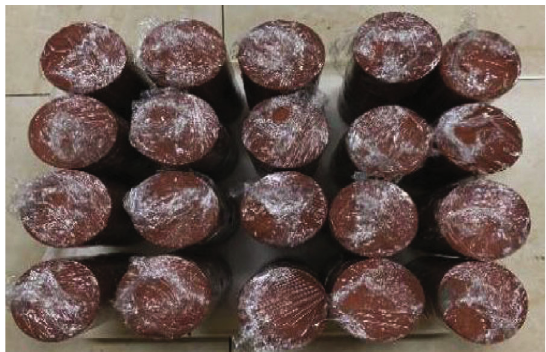
Figure 3: Indoor environment, cling fi lm wrapped specimen watering maintenance.